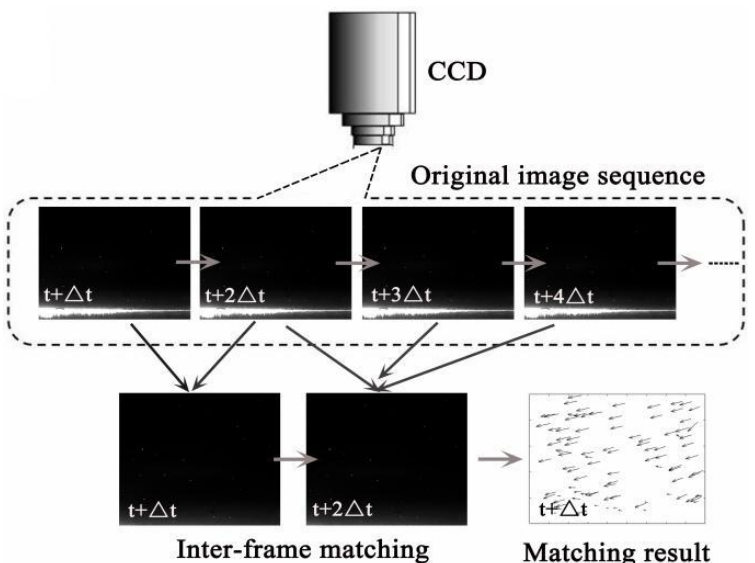
Figure 4. The post-processing